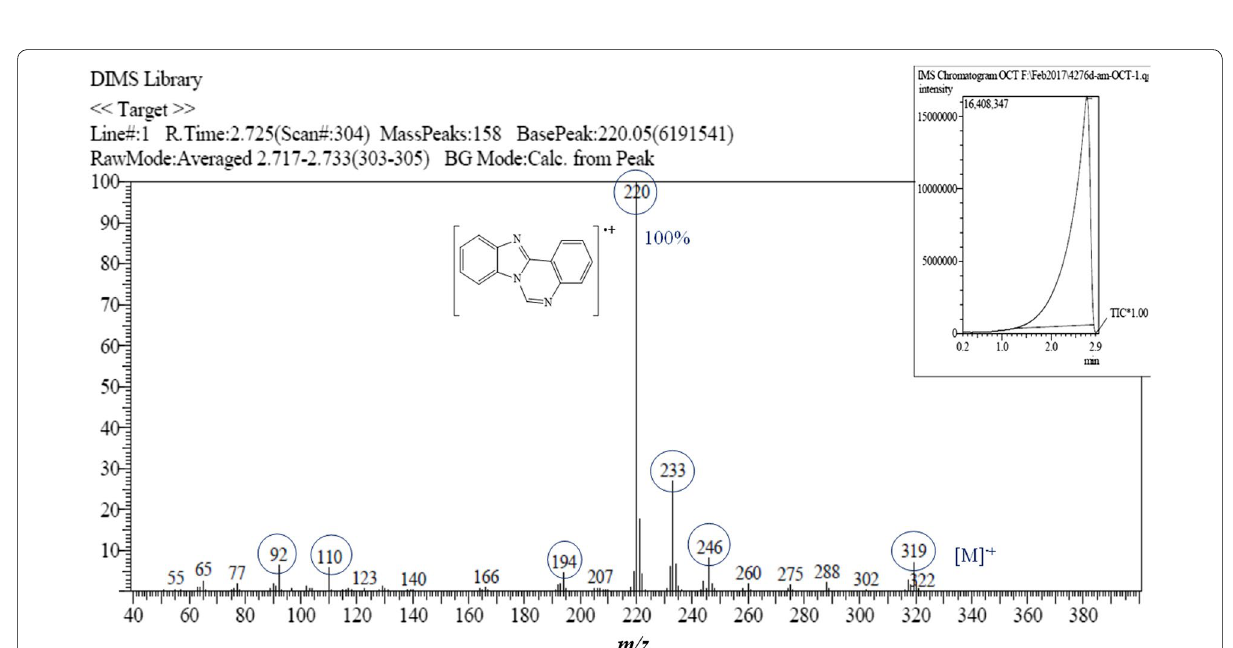
Fig. 5 DIMS spectrum of OCT with the main